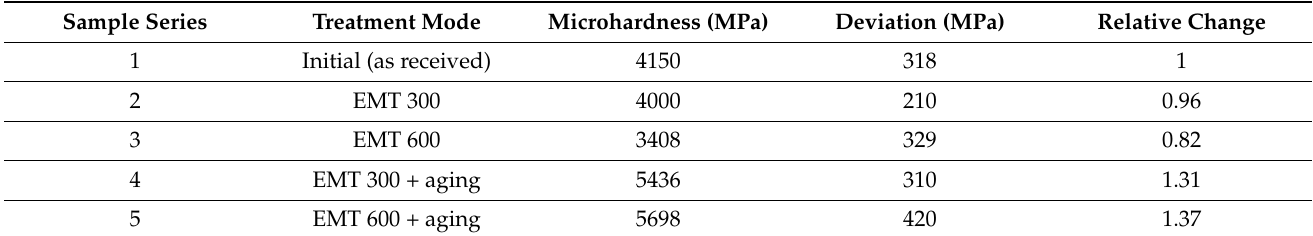
Table 4. Comparison of microhardness at different treatment